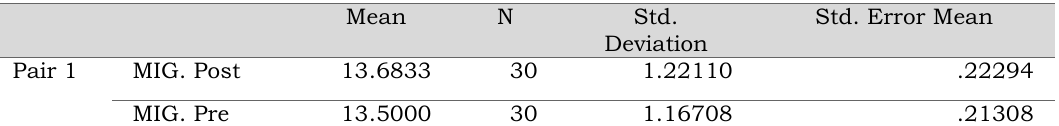
Table 5. Results of descriptive statistics comparing the pretest and posttest scores of the MIG learners